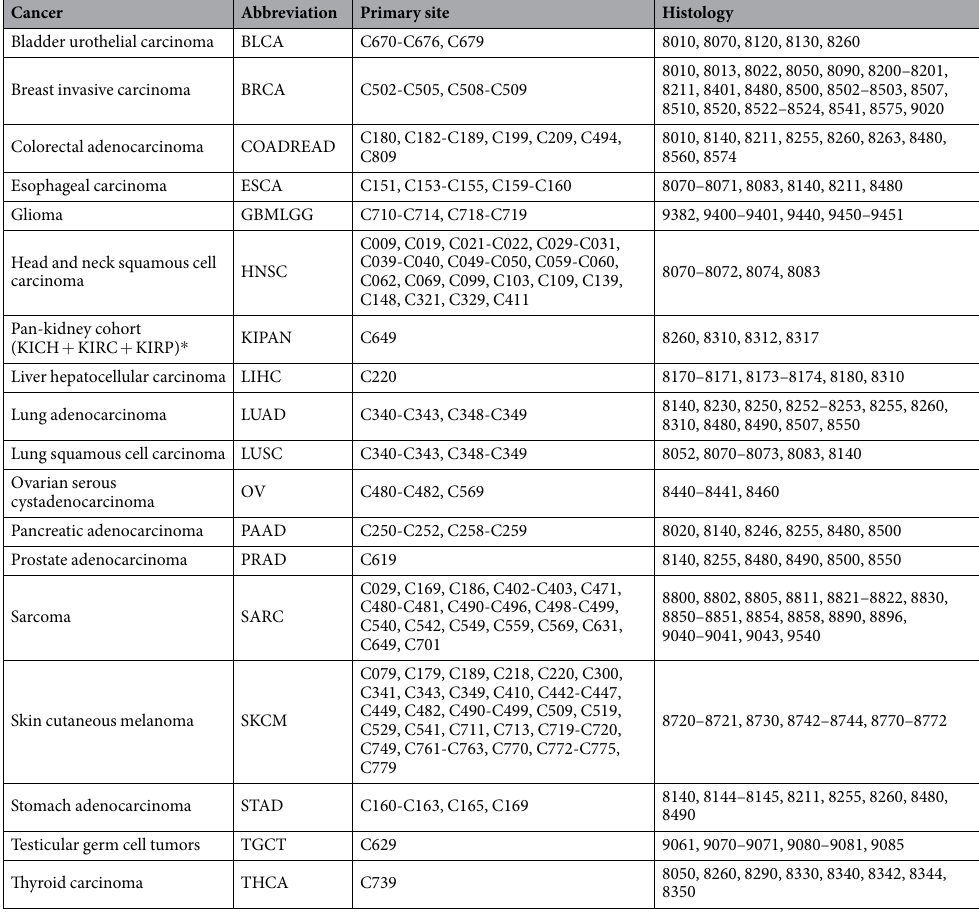
Table 4. TCGA cancer definitions for 18 cancer types. * KICH, kidney chromophobe; KIRC, kidney renal clear cell carcinoma; KIRP, kidney renal papillary cell